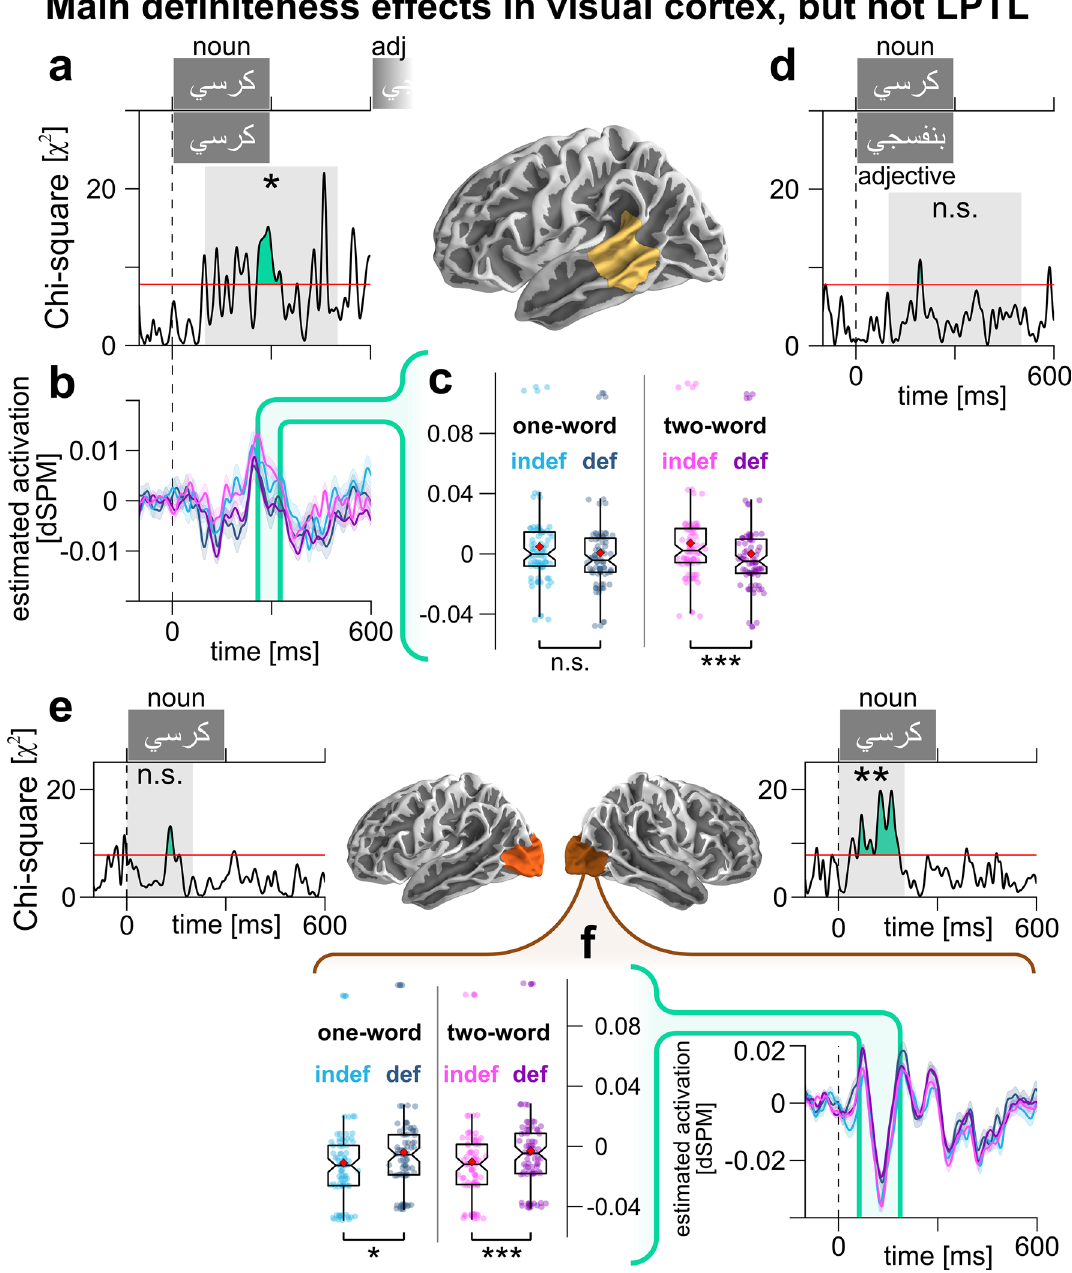
Figure 3. Follow-up analyses in the LPTL and visual cortex. ( a ) Model comparison results assessing the effect of noun definiteness, block type, and their interaction in the noun window. Red line indicates cluster-forming threshold. ( b ) Model-based estimated marginal means of LPTL per condition, with cluster from ( a ) shown in green. ( c ) Estimated marginal means of LPTL activation within cluster. Significance bars show corrected pairwise comparisons. ( d ) Model comparison results assessing the effect of word definiteness, syntactic category, and their interaction in single-word blocks. ( e ) Same as ( a ), but in the lateral occipital cortex, bilaterally, and in an earlier test window (0–200 ms). ( f ) Model-based estimated marginal means per condition over time (right) and averaged within cluster